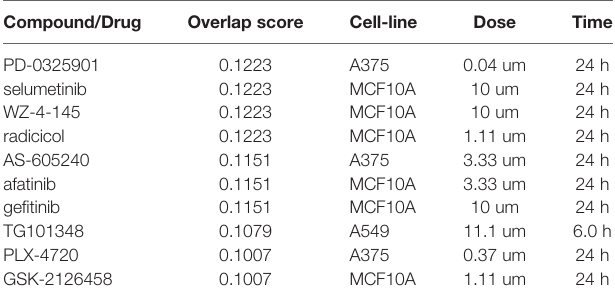
TABLE 2 | Compounds with signatures overlapping with the immunomodulatory signature of GN25. Compound/Drug Overlap